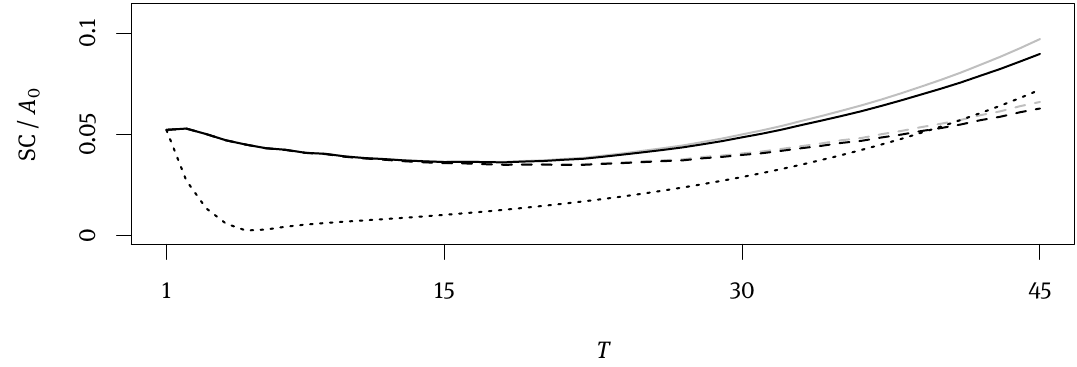
Figure 7: Solvency capital invested in zero-coupon longevity bonds (black curves) compared with those invested in zero-coupon bonds (grey curves) with the complete model in proportion of the initial value of the portfolio, and with x S = 0 and x P = 95 % : solvency capital under SII (dotted line), at maturity (dashed line) and at ruin (solid line).